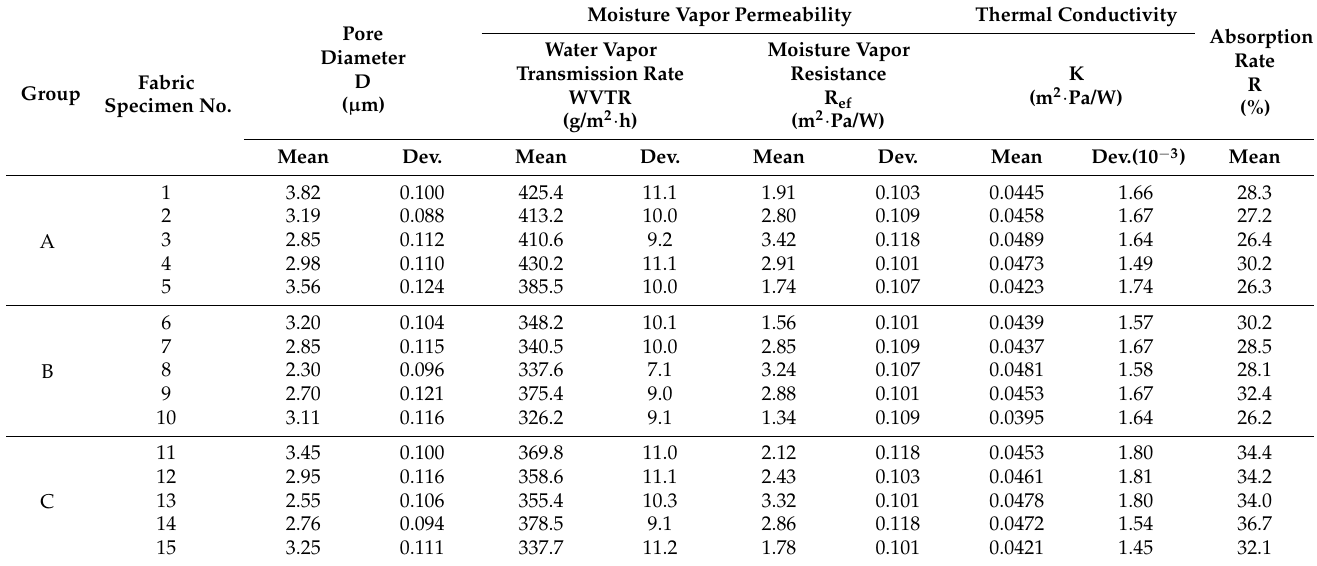
Table 4. Physical properties of the fabric specimens.